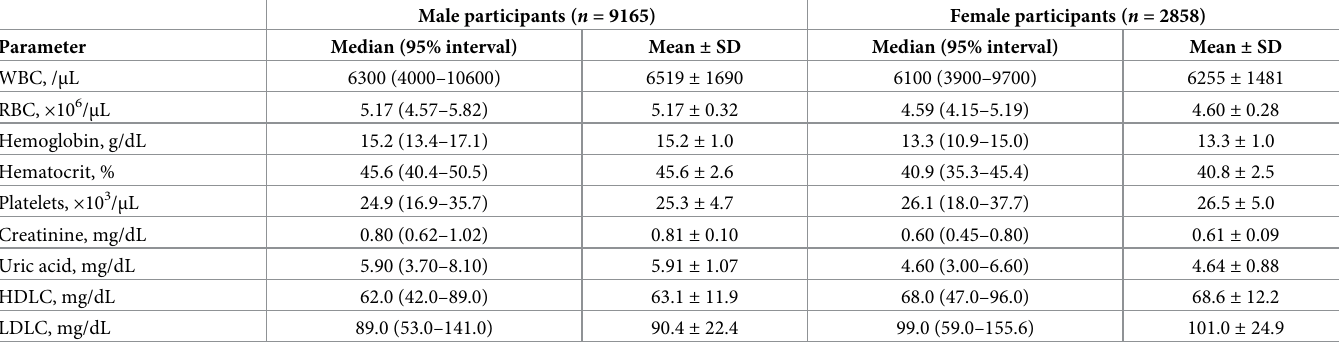
Table 2. The distributions of hematologic and biochemical values in Japanese high-school adolescents, stratified according to